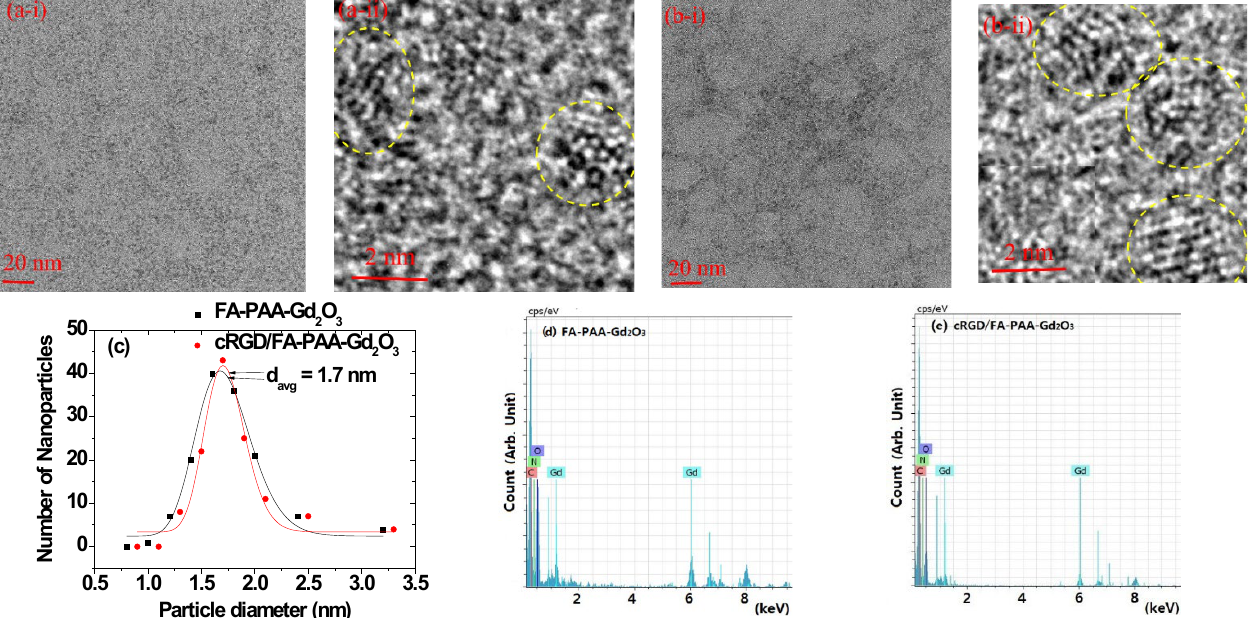
Figure 2. TEM images of ( a-i , a-ii ) FA-PAA-Gd 2 O 3 and ( b-i , b-ii ) cRGD/FA-PAA-Gd 2 O 3 nanoparticles at 20 and 2 nm scales. The yellow circles indicate individual nanoparticles. ( c ) Log-normal function fit of the observed particle diameter distributions to estimate d avg values. EDS spectra of ( d ) FA- PAA-Gd 2 O 3 and ( e ) cRGD/FA-PAA-Gd 2 O 3 nanoparticles to confirm presence of C, O, N, and Gd in the nanoparticles.